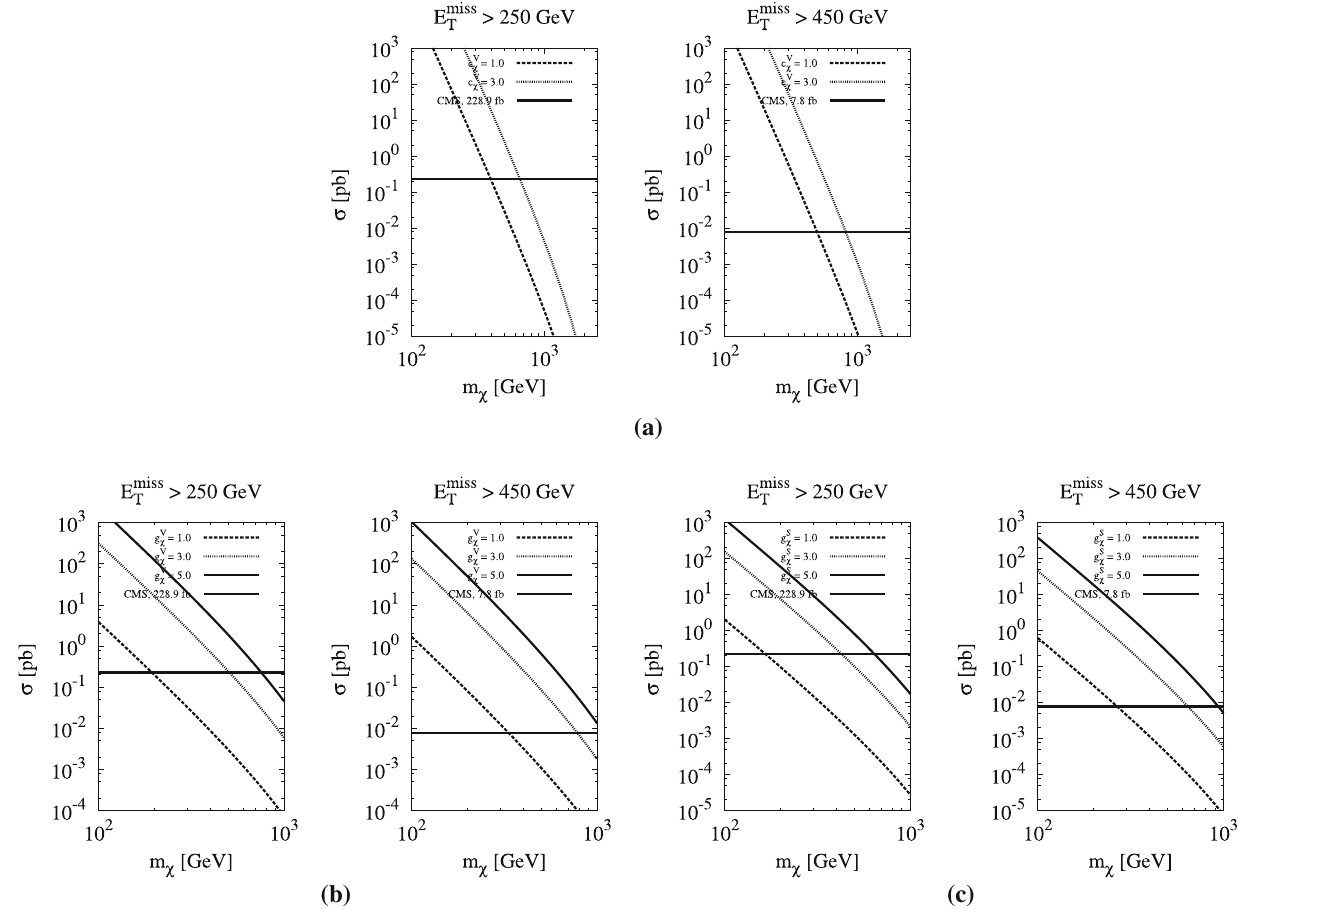
Fig. 4 The monojet cross-section in [pb] at the LHC with missing dimension-4 interaction whereas b and c correspond and dimension-5 > 250GeV and (2) E miss > energy for two case viz. (1) E miss vector and scalar interactions respectively at 1 TeV cut-off. The mono- T T jet cross-section from 8 TeV CMS collaboration data [28] based on an 450GeV. The cross-sections are obtained for all masses and couplings integrated luminosity 19 . 7fb − 1 is shown by solid black consistent with the observed relic density. a , b Corresponds to the